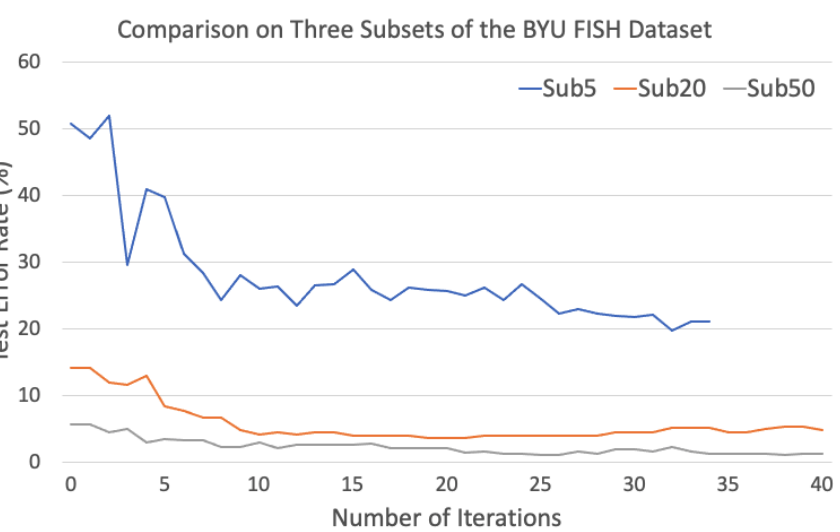
Figure 10. Performance comparison on three subsets of the BYU Fish training data for different number of training